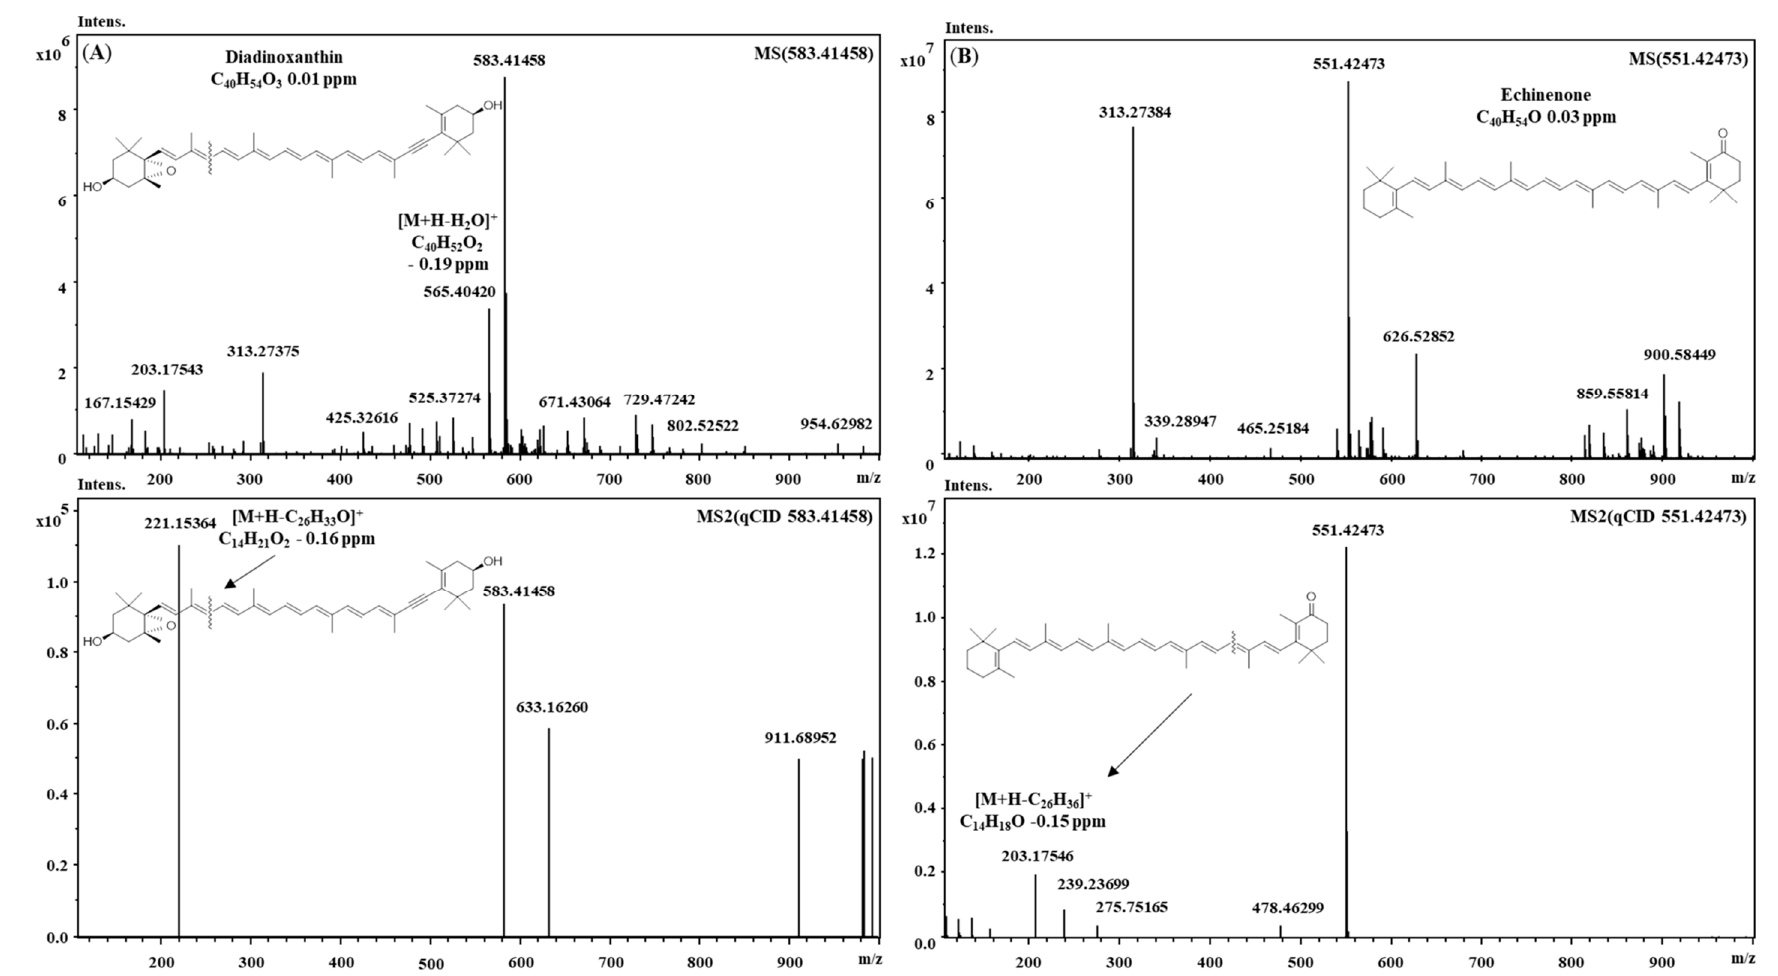
Figure 1. MS ( top ) and MS/MS ( bottom ) spectra showing structure elucidation and fragmentation pattern of peak 3 diadinoxanthin ( A ) and peak 18 echinenone ( B ).